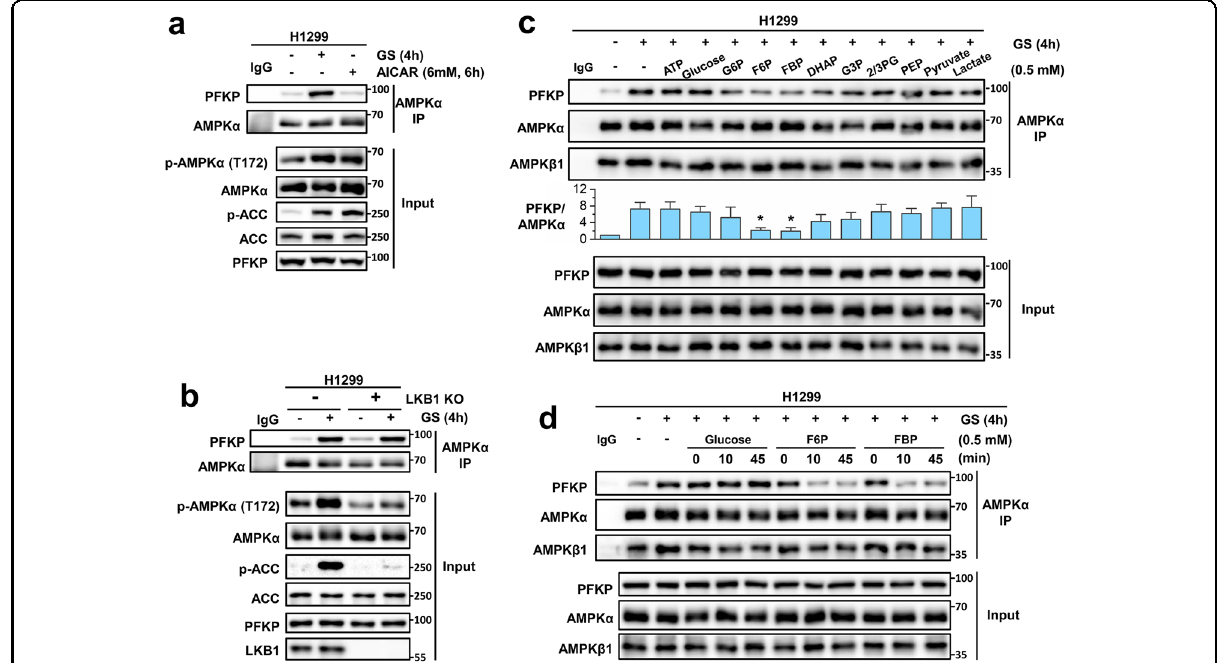
Fig. 3 The PFKP-AMPK interaction is independent of AMPK activity but regulated by PFKP-associated metabolites. a AMPK α IP in H1299 cells under control, GS, or AICAR treatment. b AMPK α IP in H1299 cells with or without LKB1 under control or GS. c AMPK α IP in H1299 cells under control or GS. The indicated metabolites were incubated with the cell lysate at room temperature for 30 min followed by IP. The difference between GS samples with or without metabolites were compared. d AMPK α IP in H1299 cells under control or GS. Glucose, F6P, and FBP were incubated with the cell lysate at room temperature for 0, 10, or 45 min followed by IP. Data are shown as means ± SD with three biological replicates. * P < 0.05, ** P < 0.01, *** P < 0.001 by two-tailed Student ’ s t -test. G6P Glucose-6-Phosphate, F6P Fructose-6-Phosphate, FBP Fructose-1,6-bisphosphate, DHAP Dihydroxyacetone-Phosphate, G3P Glyceraldehyde-3-Phosphate, 2/3PG 2/3-Phosphoglycerate, PEP